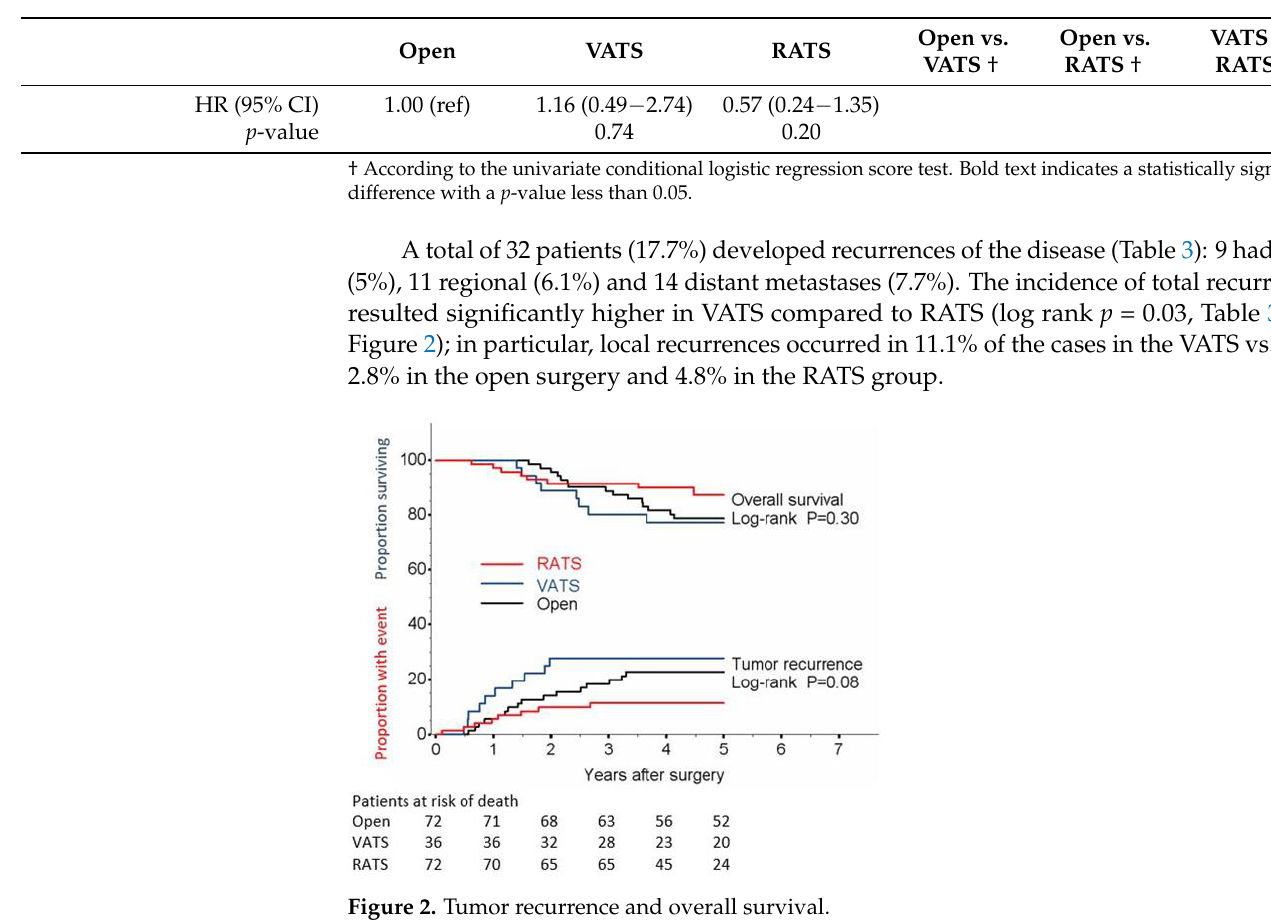
Figure 2. Tumor recurrence and overall survival.